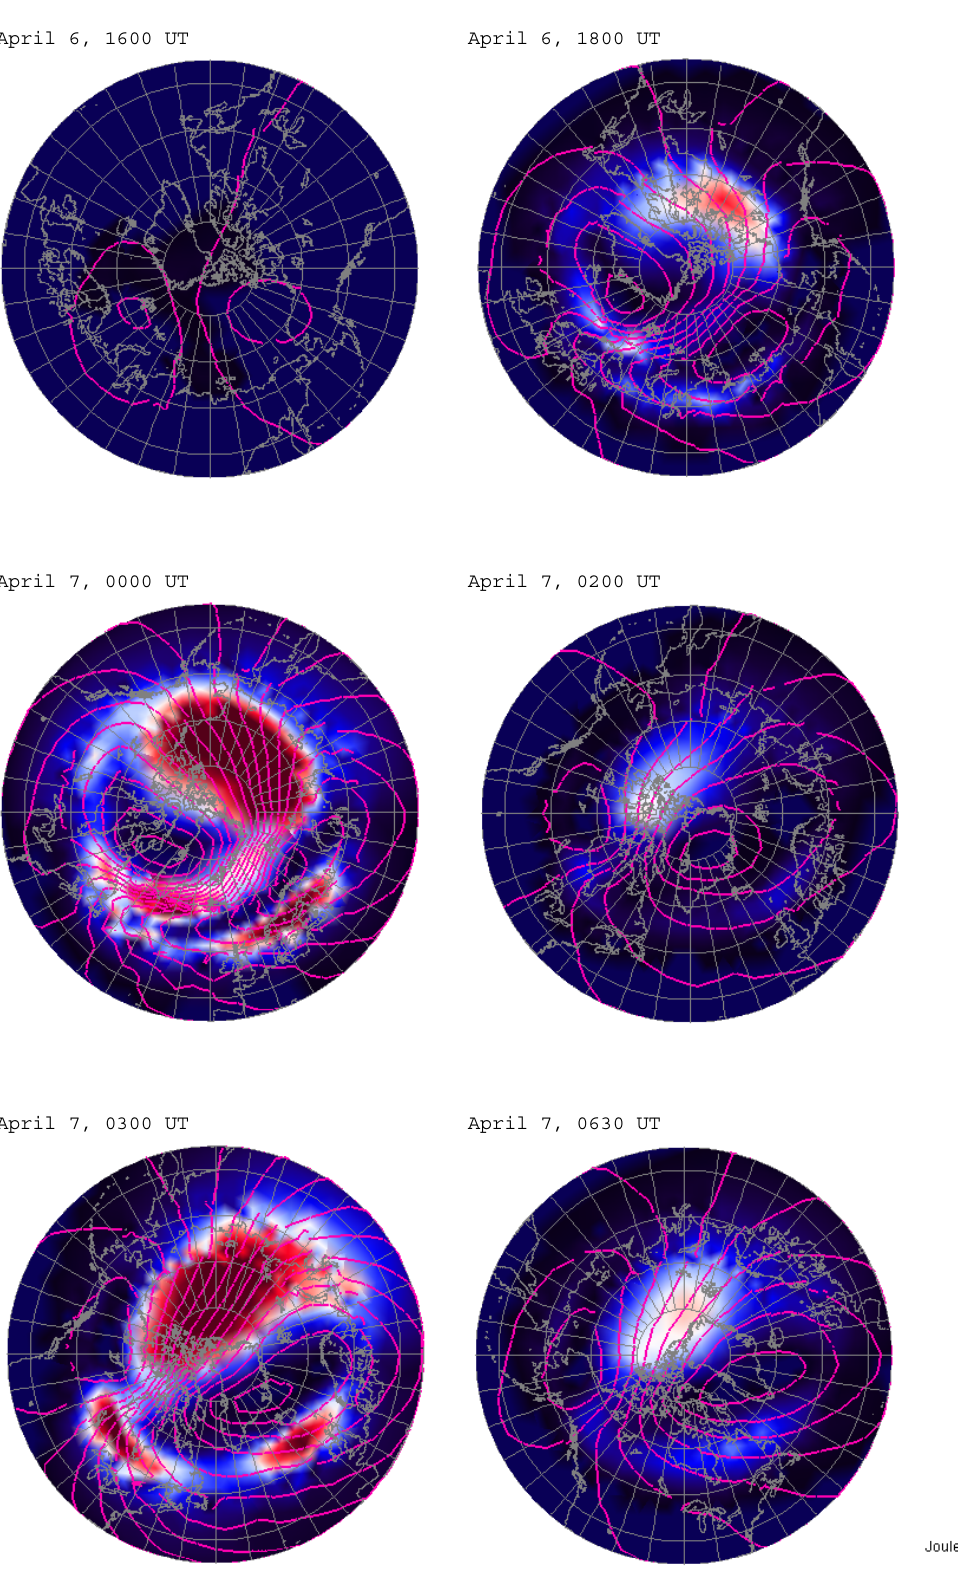
Fig. 4. Joule heating power color-coded in the simulation at six moments of time during the April 2000 storm, units Wm − 2